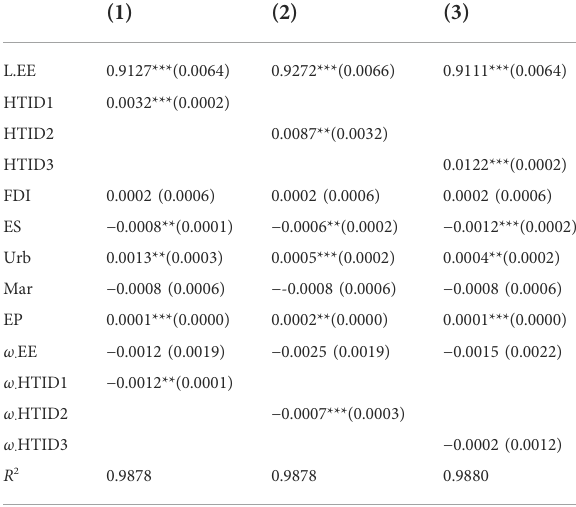
TABLE 6 Robust test of the impact of HTID on energy ef fi